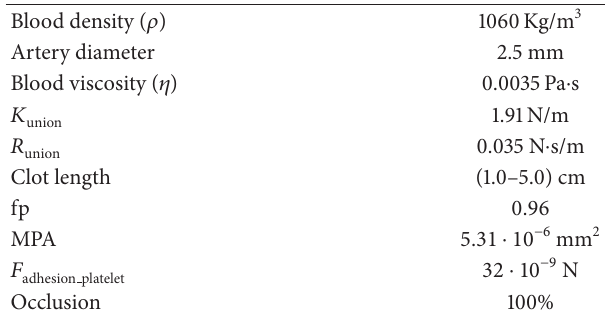
Table 1: Parameter